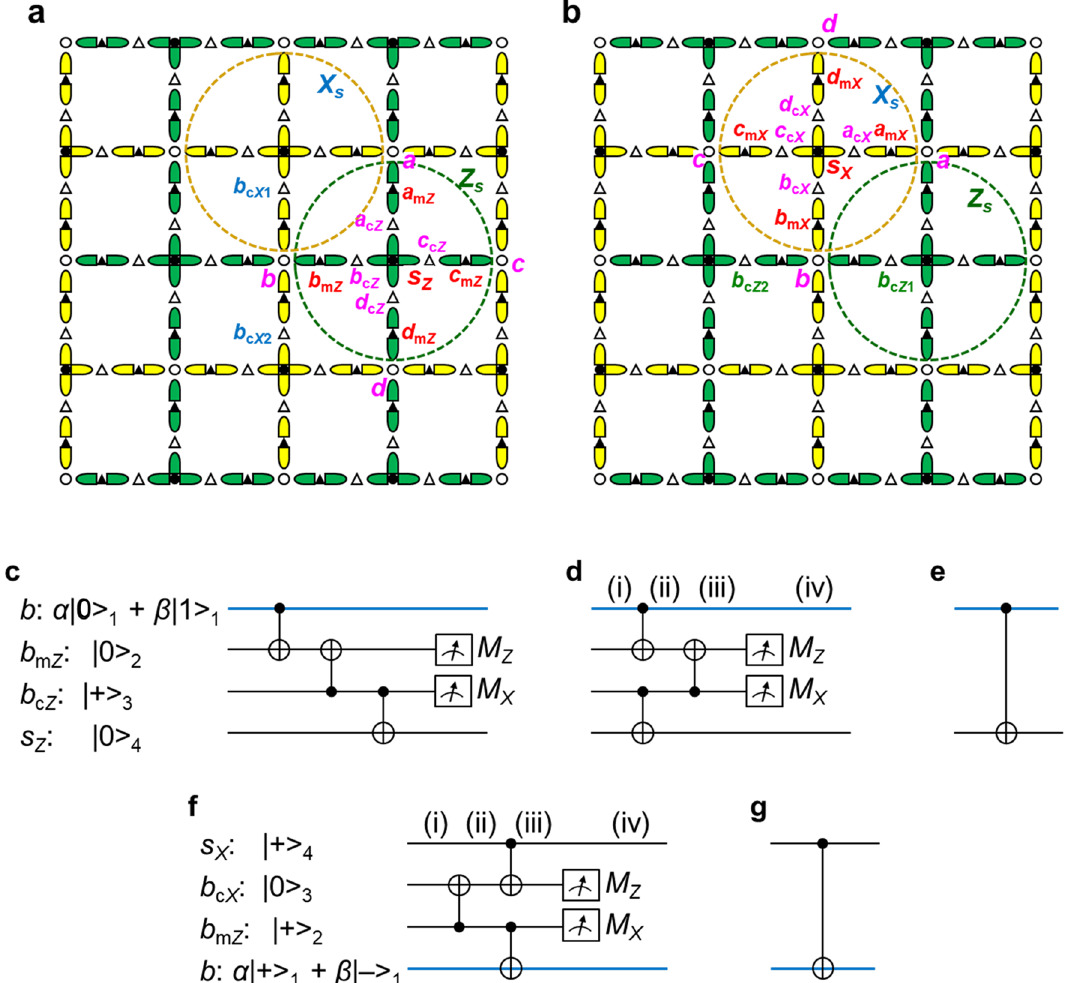
Figure 2. Qubit array where qubits are located on each edge as well as on nodes of the grid. ( a , b ) Open and black circles respectively are data and syndrome qubits, which are configured on the nodes, similar to the ordinary surface code. Qubits indicated by black triangles work as a mediator that transfers the information on a data qubit to a copy qubit indicated with an open triangle. Dashed circles are a guide to visualize data qubits belonging to a stabilizer; green and yellow dashed circles show Z - and X -stabilizers, respectively. Symbols are mainly allocated for a Z -stabilizer in ( a ) and for an X -stabilizer in ( b ). ( c ) Circuit for an operation equivalent to CNOT with qubits b and s Z as a control and a target, respectively; the information on b is transferred to a copy qubit b c Z with the help of a mediator qubit b m Z ; in place of b , b c Z performs a CNOT operation with s Z . This series of operations is completed with the measurements of b m Z and b c Z . ( d ) Circuit equivalent to ( c ). ( e ) Circuit equivalent to ( c ) and ( d ) under the feedforward being done in ( c ) and ( d ). ( f , g ) Similar to ( d ) and ( e ), but the bases for the input state are replaced with |+> and |−>